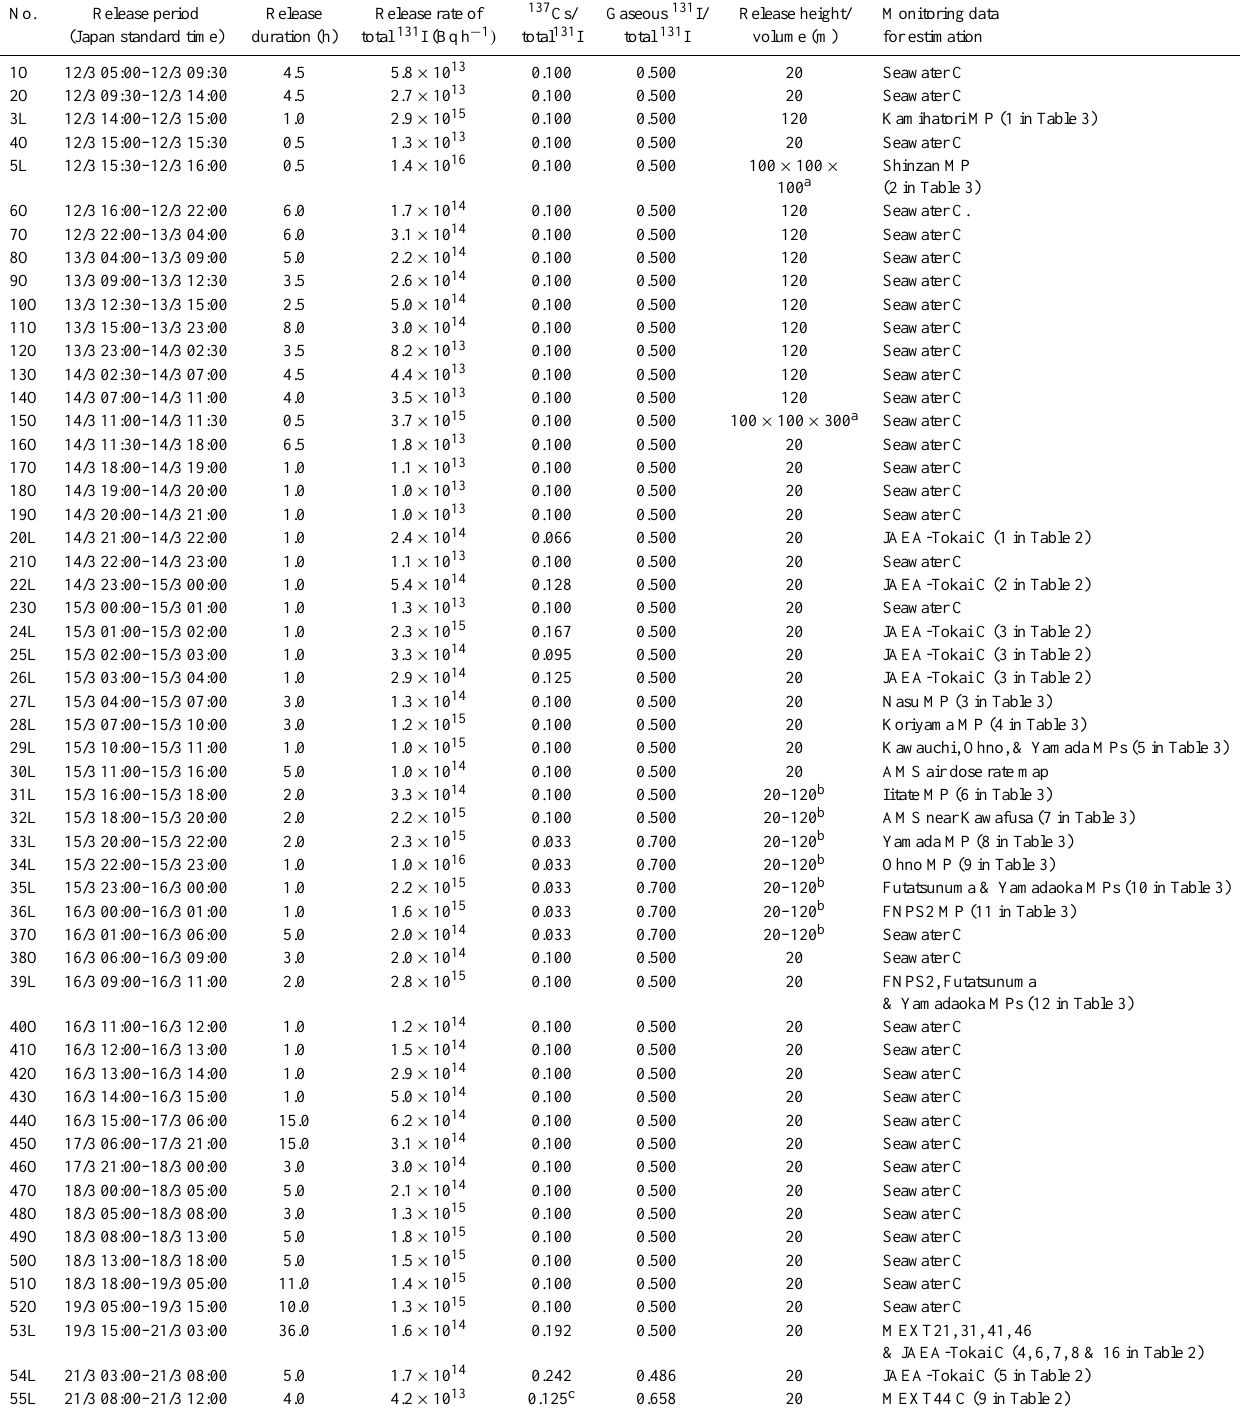
Table 6. Release period, release duration, release rate of total 131 I, radioactivity ratio of 137 Cs /total 131 I, the ratio of gaseous 131 I to total 131 I, and release height for the period between 05:00 on 12 March and 00:00 on 1 May 2011. Notations of “L” and “O” in the first column represent estimations using land and ocean environmental monitoring data, respectively. In the last column, MP: monitoring post, C: concentration, and AMS: Aerial Measuring System of the US Department of Energy/National Nuclear Security Administration (US DOE/NNSA,